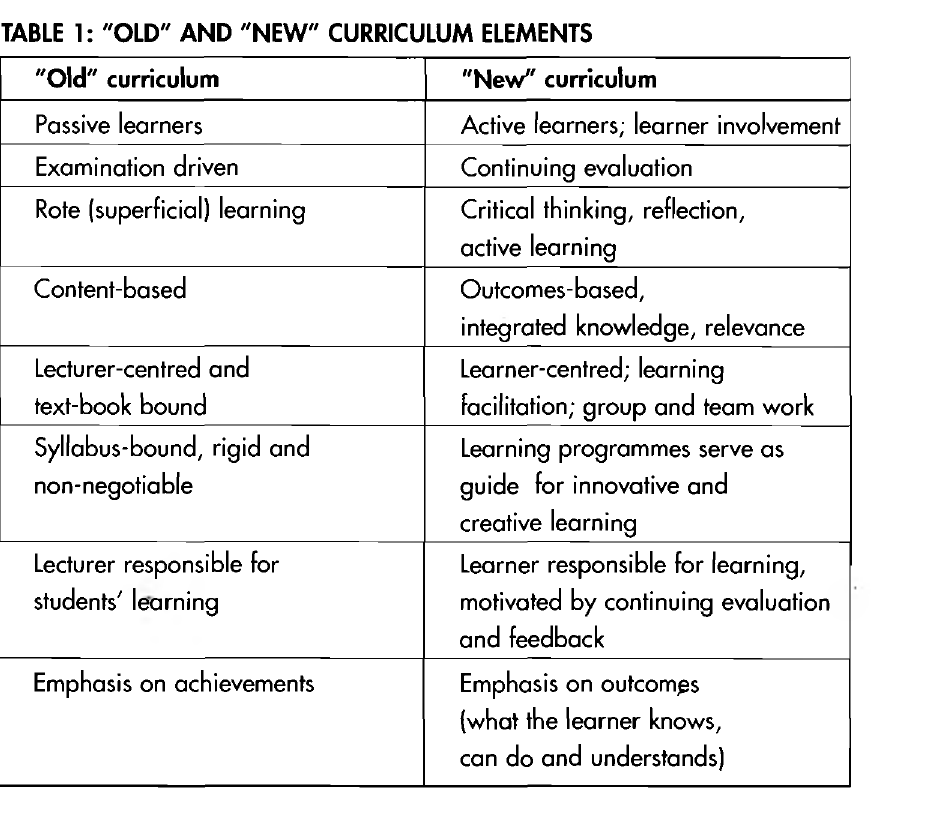
TABLE 1: "OLD" AND "NEW" CURRICULUM